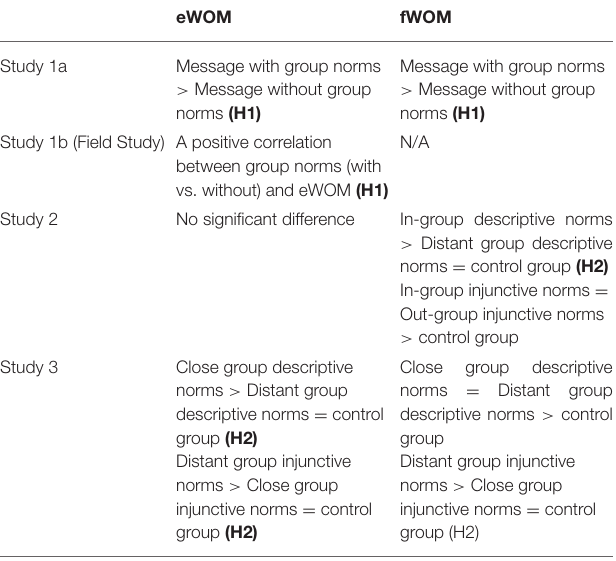
TABLE 1 | Results summary of Study